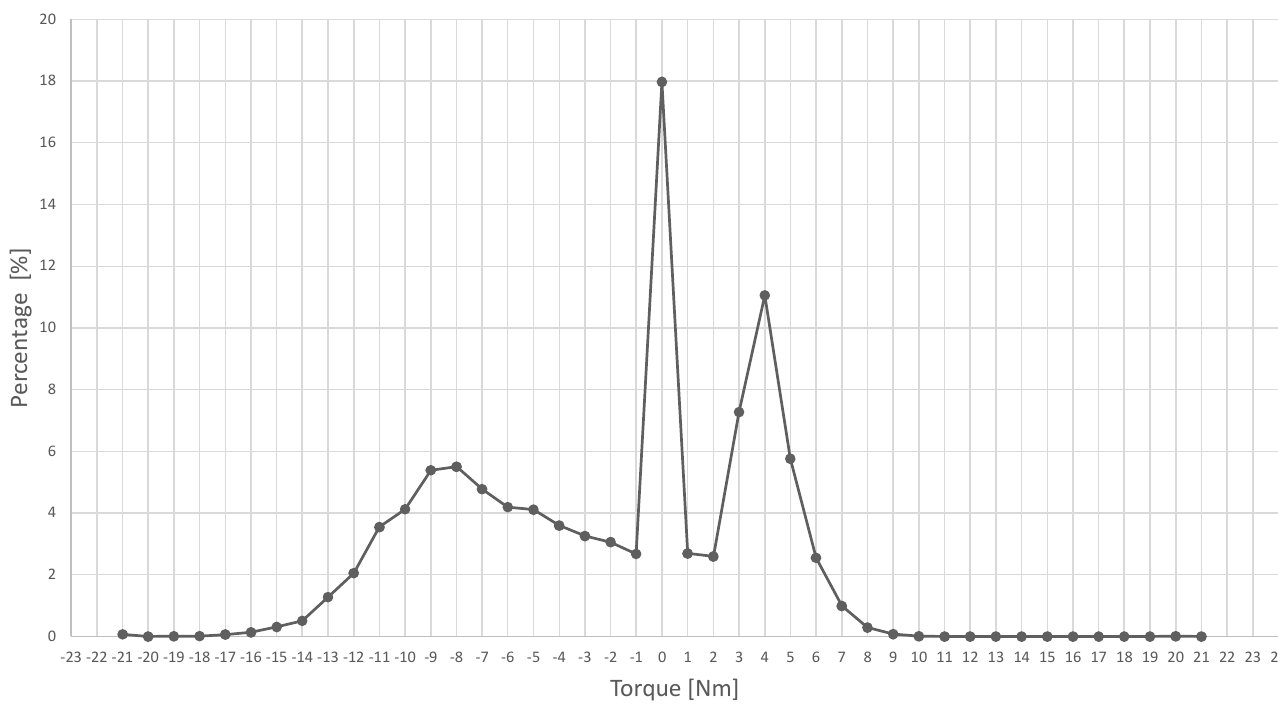
Figure 11. Occurrence of the torques over an Endurance applied to the gearbox input shaft .